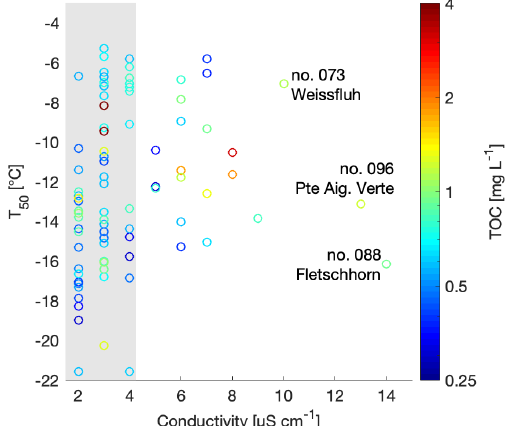
Figure 4. Scatterplot of T 50 versus conductivity. TOC is shown in color and the three most conductive samples are labeled with the sample number and sampling site. The range of the conductivity instrument background is shaded in